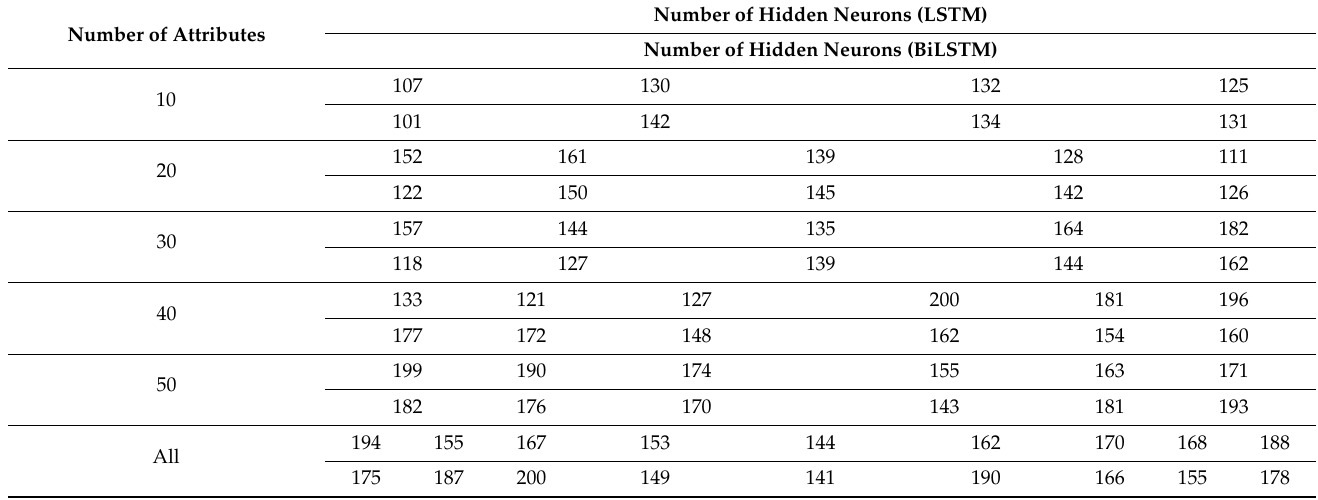
Table 6. Optimized number of hidden neurons for cancer stage classification. (Illustrations by the